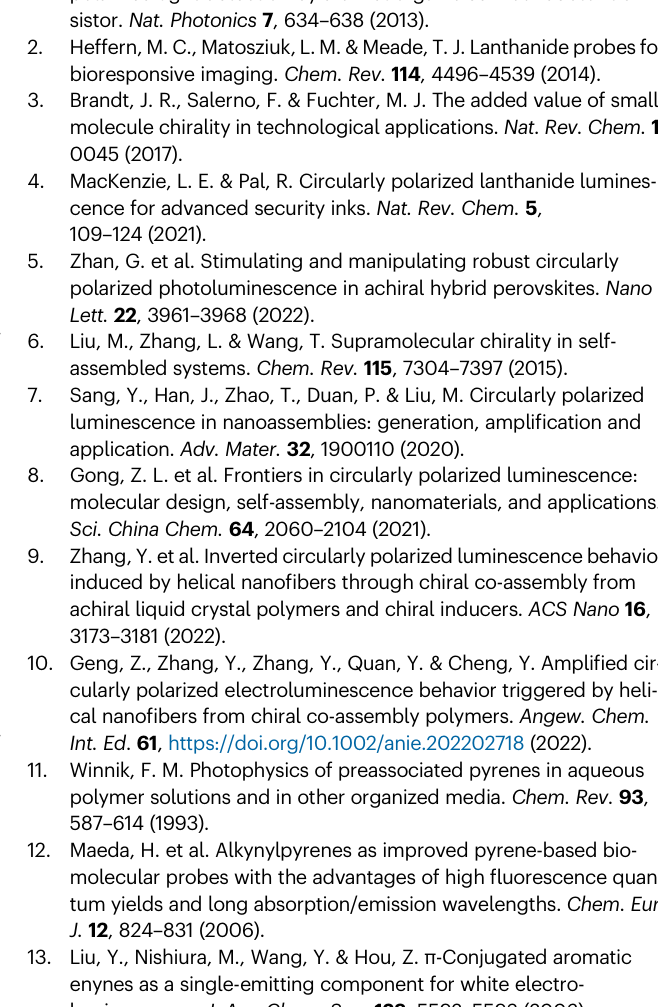
Supplementary Figs. 12a and 14, R -M-(PyBO) 4 -D fresh fi lm had a